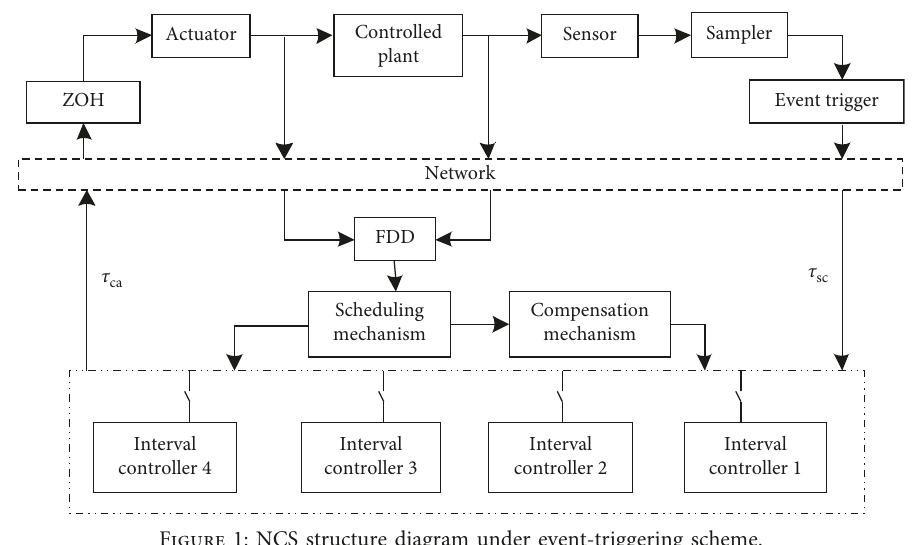
Figure 1: NCS structure diagram under event-triggering